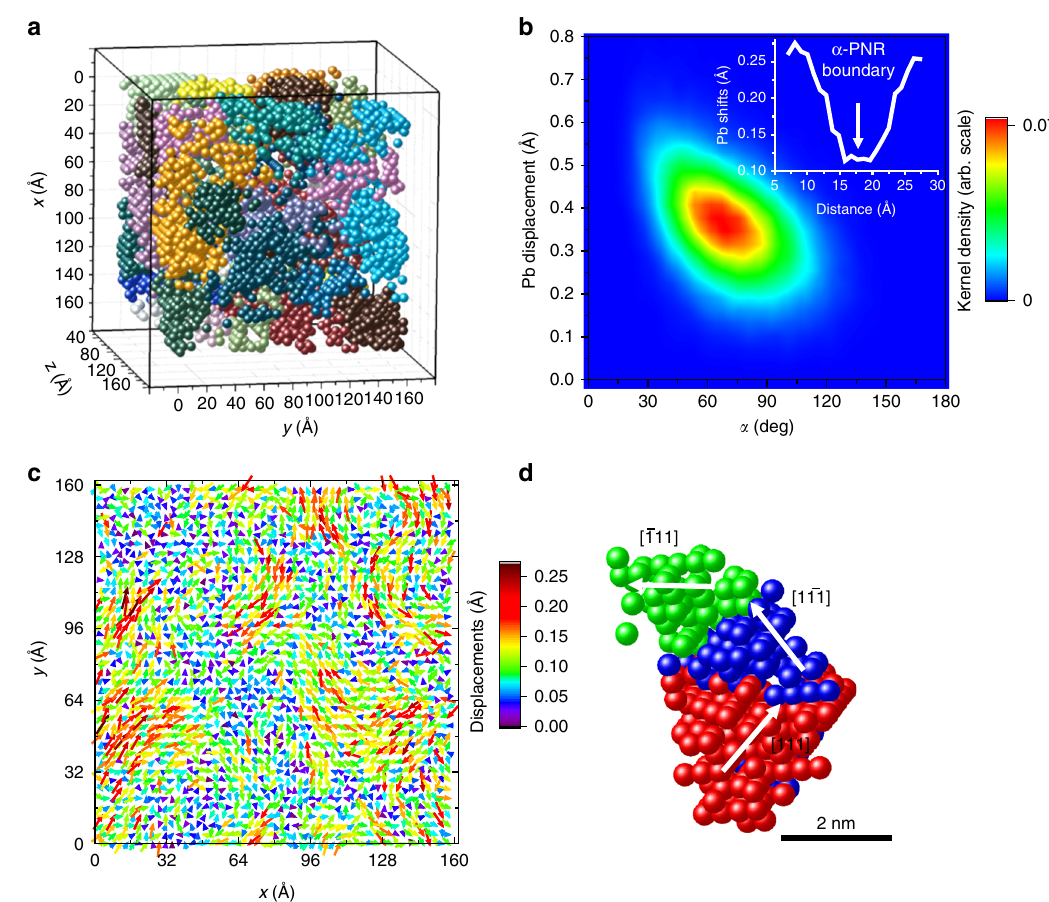
Fig. 4 Correlations among the Pb displacements. a Clusters of Pb atoms having a local displacement-alignment metric α (see text) for the fi rst Pb – Pb coordination sphere less than 45° (spatially distinct clusters are labeled using different colors). As a reference, α = 0° and α = 180° correspond to the parallel and antiparallel displacements of a given atom and its neighbors, respectively. The clusters have been identi fi ed according to the HDBSCAN 33 algorithm. The search procedure accounted for the periodic boundary conditions; however, for visualization purposes, we assigned a distinct color to each region within the con fi guration box. b Magnitudes of the Pb displacements plotted against α ; a strong negative correlation between the two characteristics is observed. The inset illustrates variation of the displacement magnitude for the Pb columns across the α -PNR boundary, as derived from panel c . c A 2D map of displacements for the Pb columns projected onto a {110} plane; the color-scale bar re fl ects the displacement magnitude in Å and the arrows are used to illustrate the displacement directions. The x and y axes correspond to the orthogonal [110] and [001] directions. This distribution agrees with the analogous maps deduced from experimental atomic-resolution scanning transmission electron microscopy images of PbMg 1/3 Nb 2/3 O 3 . The displacements decay monotonically toward the boundaries. d 3D rendering of a representative α -PNR, with the constituent Pb atoms (represented by spheres) that are displaced along the inequivalent 〈 111 〉 directions (labeled in the fi gure) indicated using different